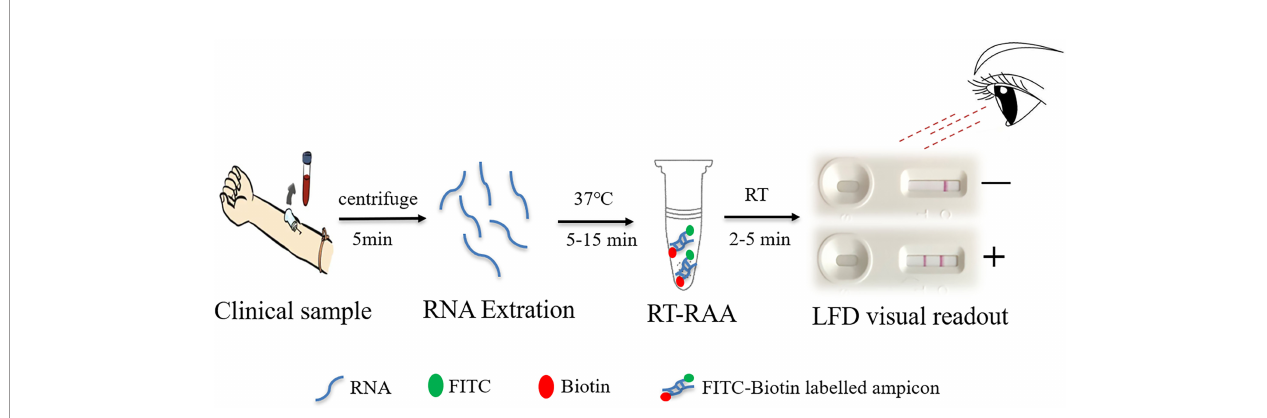
FIGURE 1 | Schematic representation of the reverse transcription recombinase-aided ampli fi cation – lateral fl ow dipstick (RT-RAA-LFD) work fl ow for hepatitis C virus. RNA extraction for 15 min, RT-RAA reaction for 5 min, and LFD visual readout for 5 to 10 min. All work was performed within 30 min with minimal